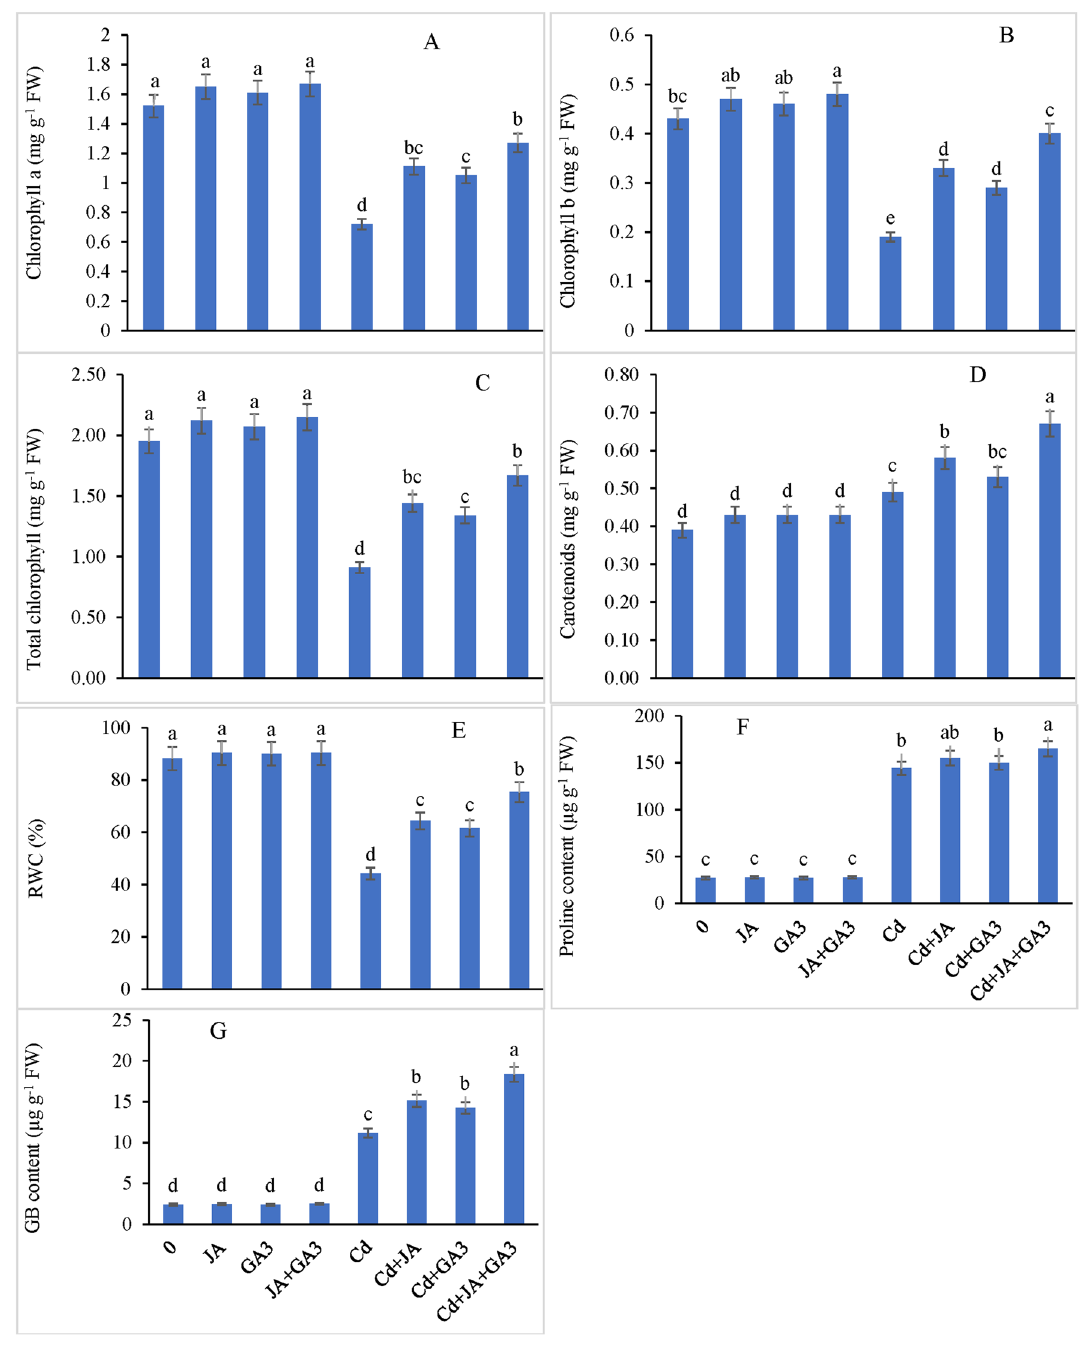
Figure 2. Restoration of ( A ) chlorophyll a, ( B ) chlorophyll b, ( C ) total chlorophyll, ( D ) carotenoid content, ( E ) RWC: relative water content, ( F ) proline content, and ( G ) GB: glycinebetaine in Cd-stressed chickpea plants by external supplementation of JA and GA 3 applied individually and/or in combination (Mean ± plants (Fig. 4A). Higher APX activity (171.85%) was observed in Cd-treated chickpea plants when JA and GA 3 were applied in combination. While comparing with the controls, the GR activity was found to be triggered by 46.78% in the Cd-stressed chickpea plants (Fig. 4B). Furthermore, JA-pre-treated Cd stressed plants (Cd + 1 nM JA) showed increased GR activity by 99.50%, whereas GA 3 + Cd increased the GR activity by 95.71% compared with the controls. The combined application of JA and GA 3 further enhanced the GR activity by 148.92% in the Cd treated plants with respect to the control. Cadmium stress decreased the activity of DHAR by 46.78% and MDHAR by 45.90% compared with the controls (Fig. 4C,D). However, JA-priming resulted in a less decrease in DHAR and MDHAR activities by 15.08% and 23.11%, respectively, under Cd stress. Foliar addition of GA 3 in Cd-supplemented plants also recorded less decrease in the activity of DAHR by 24.45% and MDHAR by 28.26%. The combined application of JA and GA 3 to the Cd-stressed plants showed a minimal decrease by 7.36% and